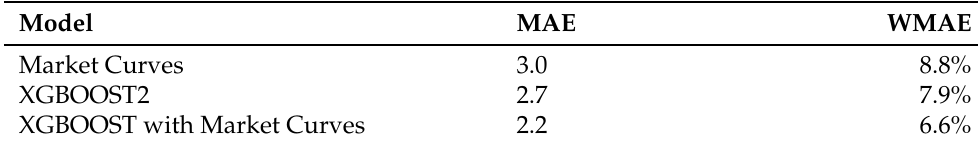
Table 2. Using the market curve forecasts in the XGBOOST clearly improves the forecasts.